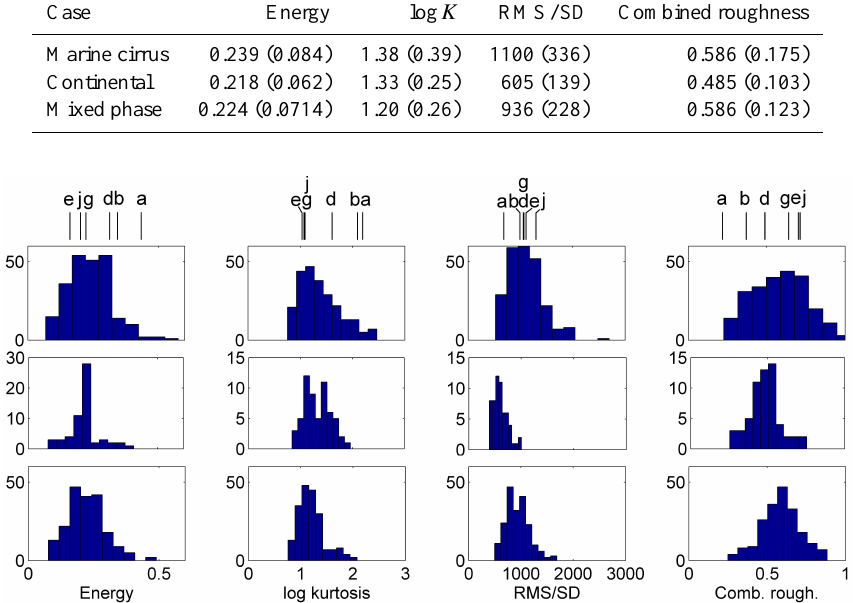
Fig. 6. Frequency distributions of roughness measures obtained from SID-3 2-D patterns in marine air mass cirrus (top row), continental air mass cirrus (middle row), and mixed-phase clouds (bottom row) flights. Labelled lines above the distributions show roughness measure values for six test particles from Table 3 and Fig. 7: (a) , (b) , (d) , (e) , (g) and (j) , where (a) is the smoothest and (j) the roughest one. Note that the GLCM energy and log kurtosis are anticorrelated with